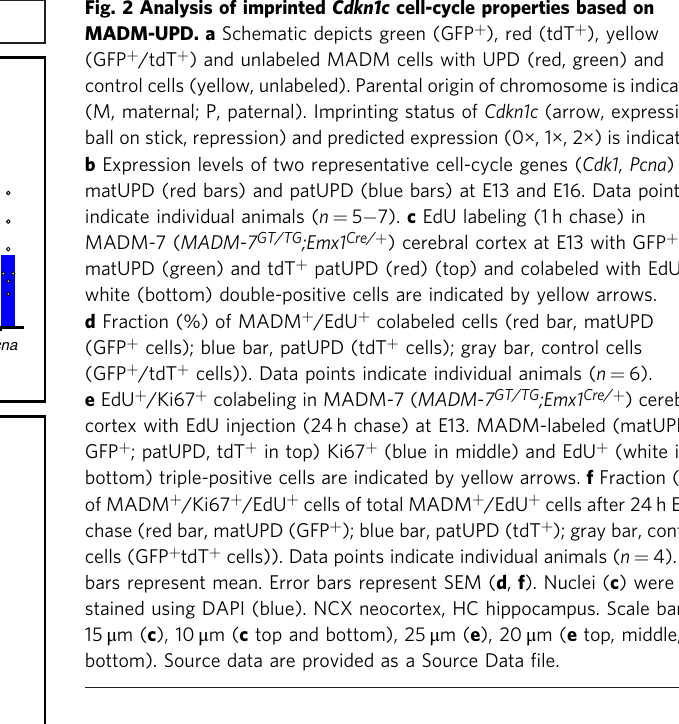
Fig. 2 Analysis of imprinted Cdkn1c cell-cycle properties based on MADM-UPD. a Schematic depicts green (GFP + ), red (tdT + ), yellow (GFP + /tdT + ) and unlabeled MADM cells with UPD (red, green) and control cells (yellow, unlabeled). Parental origin of chromosome is indicated (M, maternal; P, paternal). Imprinting status of Cdkn1c (arrow, expression; ball on stick, repression) and predicted expression (0×, 1×, 2×) is indicated. b Expression levels of two representative cell-cycle genes ( Cdk1 , Pcna ) in matUPD (red bars) and patUPD (blue bars) at E13 and E16. Data points indicate individual animals ( n = 5 − 7). c EdU labeling (1 h chase) in MADM-7 ( MADM-7 GT/TG ;Emx1 Cre/ + ) cerebral cortex at E13 with GFP + matUPD (green) and tdT + patUPD (red) (top) and colabeled with EdU in white (bottom) double-positive cells are indicated by yellow arrows. d Fraction (%) of MADM + /EdU + colabeled cells (red bar, matUPD (GFP + cells); blue bar, patUPD (tdT + cells); gray bar, control cells (GFP + /tdT + cells)). Data points indicate individual animals ( n = 6). e EdU + /Ki67 + colabeling in MADM-7 ( MADM-7 GT/TG ;Emx1 Cre/ + ) cerebral cortex with EdU injection (24 h chase) at E13. MADM-labeled (matUPD, GFP + ; patUPD, tdT + in top) Ki67 + (blue in middle) and EdU + (white in bottom) triple-positive cells are indicated by yellow arrows. f Fraction (%) of MADM + /Ki67 + /EdU + cells of total MADM + /EdU + cells after 24 h EdU chase (red bar, matUPD (GFP + ); blue bar, patUPD (tdT + ); gray bar, control cells (GFP + tdT + cells)). Data points indicate individual animals ( n = 4). All bars represent mean. Error bars represent SEM ( d , f ). Nuclei ( c ) were stained using DAPI (blue). NCX neocortex, HC hippocampus. Scale bar, 15 μ m ( c ), 10 μ m ( c top and bottom), 25 μ m ( e ), 20 μ m ( e top, middle, bottom). Source data are provided as a Source Data fi